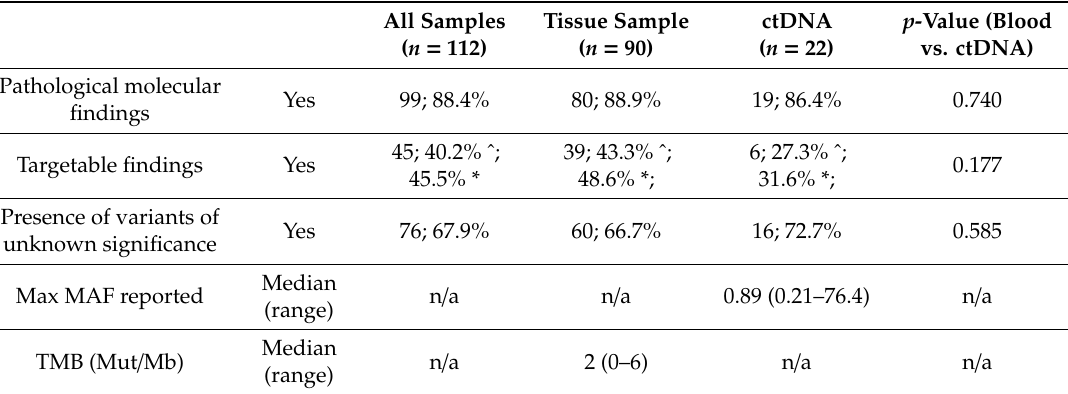
Table 2. Molecular profiling-derived findings